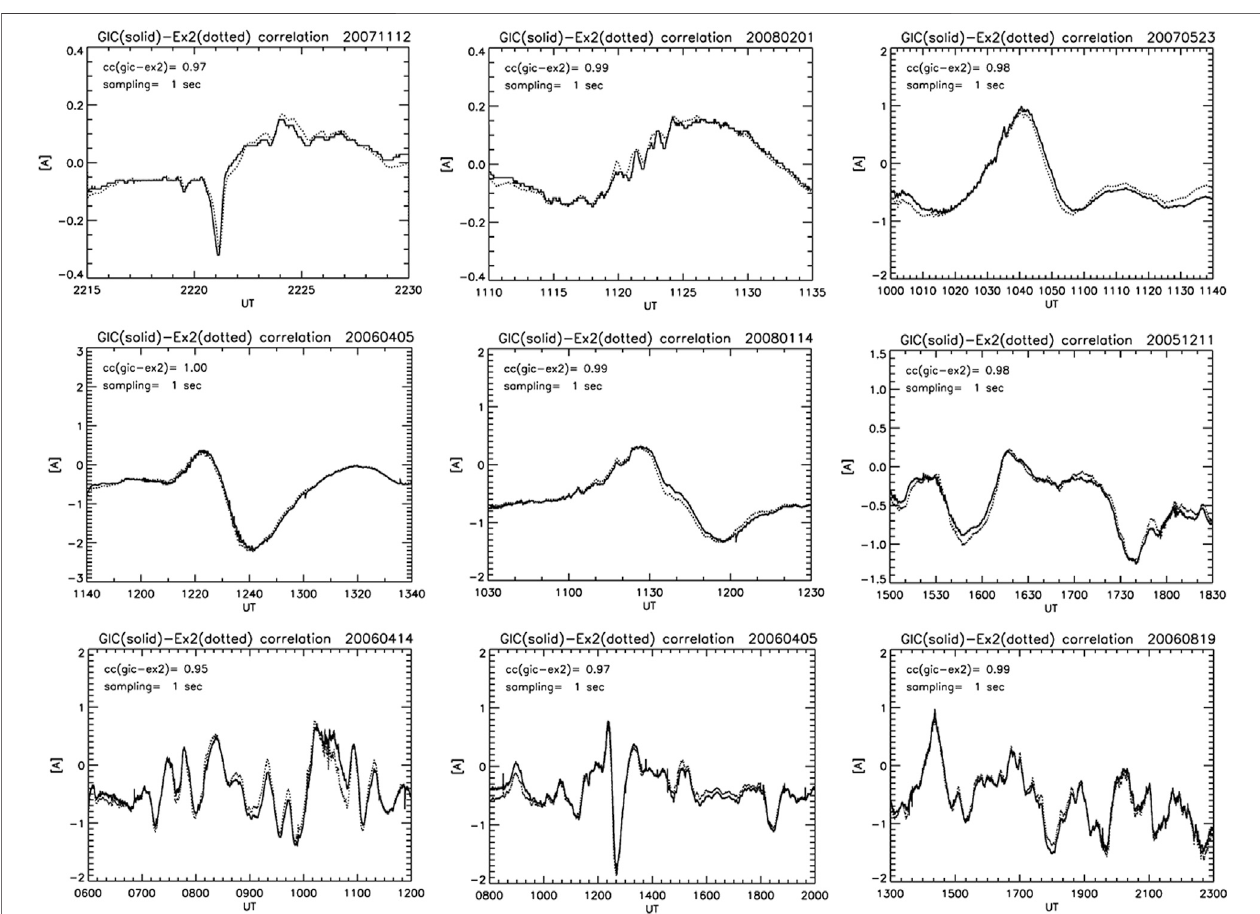
FIGURE7| ObservedGIC(solidcurve)and E x2 scaledtotheGIC(dottedcurve)duringspaceweatherdisturbances;SC,Pi2,substorms,andstormswithdifferent timescales. The cc (gic-ex2) refers to the correlation coef fi cient between the GIC and E x2 , and sampling (cid:1) 1 s refers to that the original 1 s sampled GIC and B y data are used. Note that MLT (cid:1) UT +